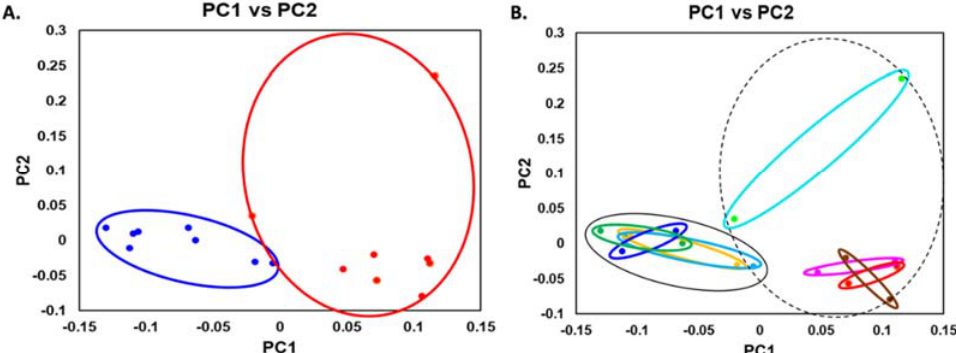
Figure 5. Beta diversity analysis of iDNA and eDNA representation of biofilms derived from the saliva of periodontally healthy (H) and periodontitis (P) patients as evaluated by weighted unifrac. Principal coordinate analysis (PCoA) is plotted according to ( A ) the type of DNA: iDNA (blue circles) and eDNA (red circles), and ( B ) periodontal status of the patients, medium condition (S—SHI; SC—SHI + 5 mM CaCl 2 ) and type of DNA: H-S-iDNA (dark blue circles), H-SC-iDNA (dark green circles), P-S-iDNA (light blue circles), P-SC-iDNA (yellow circles), H-S-eDNA (red circles), H-SC-eDNA (pink circles), P-S-eDNA (brown circles), and P-SC-iDNA (turquoise circles). All iDNA samples are indicated by a black solid line; all eDNA samples are indicated by a black dotted line.